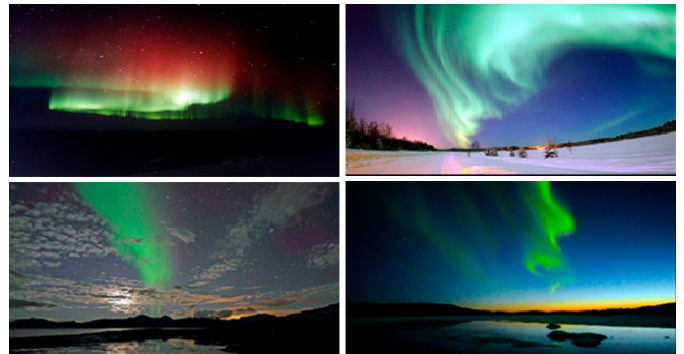
Figure 1. Auroras. Figure 1. Auroras.